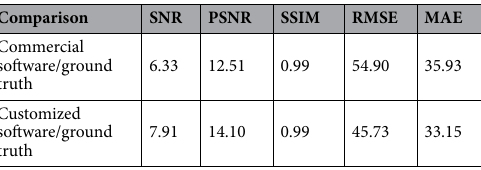
Table 1. The quantitative comparison between reconstruction performance of commercial software and customized software with the ground truth. Signal-to-Noise Ratio (SNR), Peak Signal-to-Noise Ratio